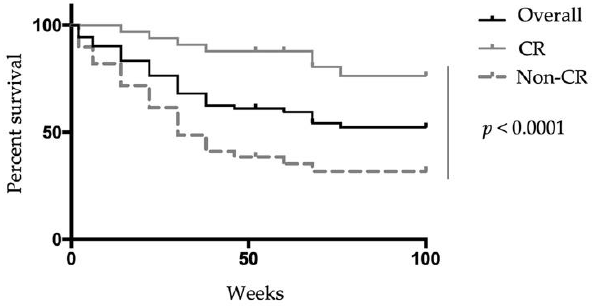
Figure 6. Clinical remission rate and relapse-free survival of patients treated with Vedolizumab. Kaplan–Meier plots for relapse-free survival of patients achieving or unable to achieve a clinical remission at week 6. Relapse-free survival was assessed using the Kaplan–Meier method. CR: Clinical remission.